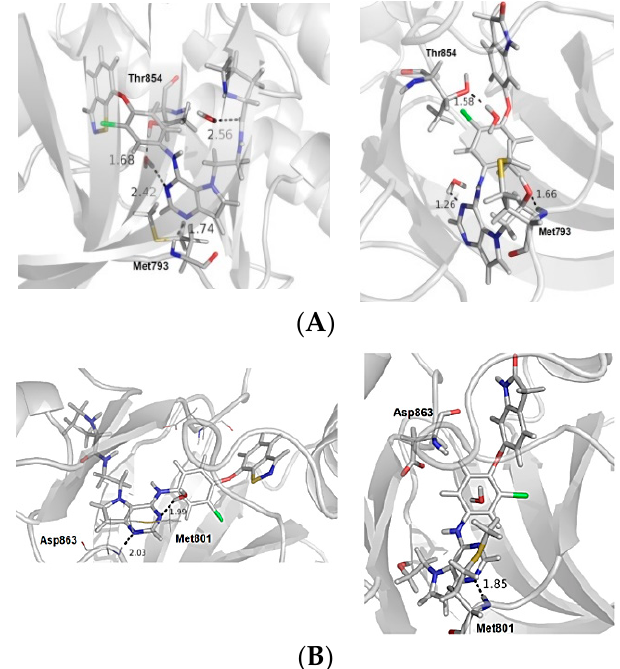
Figure 2. ( A ) The most and the least active compounds at the EGFR active site, along with the main residues (Met793 and Thr854) and two structural water molecules. ( B ) The most and least active compounds at the HER-2 active site, along with the main residues (Met801 and Asp863) and a structural water molecule. The numbers refer to distance between some residues and the ligands. We modified the figures now.